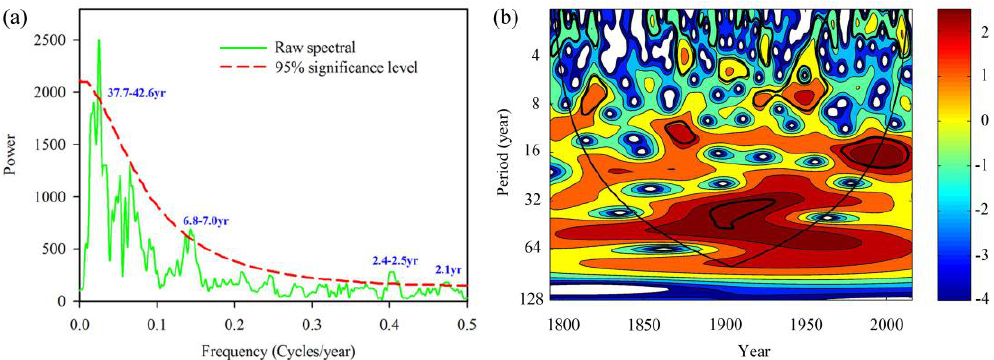
Figure 8. Multitaper method (MTM) power spectrum of the reconstructed PDSI p6-7 for the period 1792 to 2016. The 95% confidence levels relative to red noise are shown, and the numbers refer to the significant period in years ( a ). Wavelet power spectra for the PDSI p6-7 reconstruction. The black contour represents the 95% significance level, using a red-noise background spectrum ( b ).